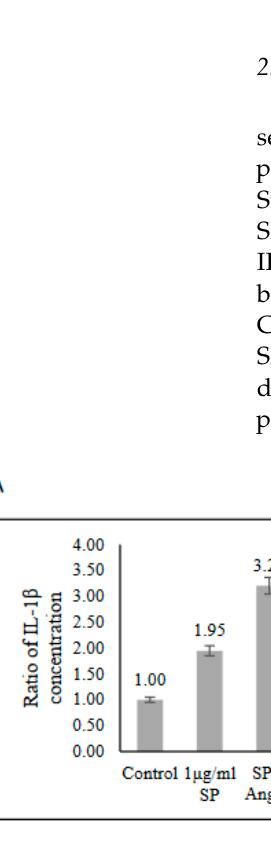
Figure 6. Cytokine levels in the supernatant of PBMCs from recovered COVID-19 patients (n = 3) after stimulation with a SARS-CoV-2 peptide pool (SP), angiotensin II (Ang II), or both of SP and Ang II. ( A ) IL-1 β . ( B ) IL-6. ( C ) IL-10. The ratio of cytokines concentrations was measured as the concentration of cytokine in each group to the concentration of cytokine in the control group.